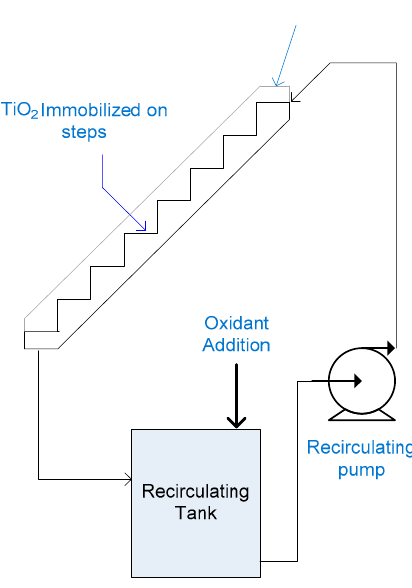
Figure 5. Schematic drawing of Step reactor system.